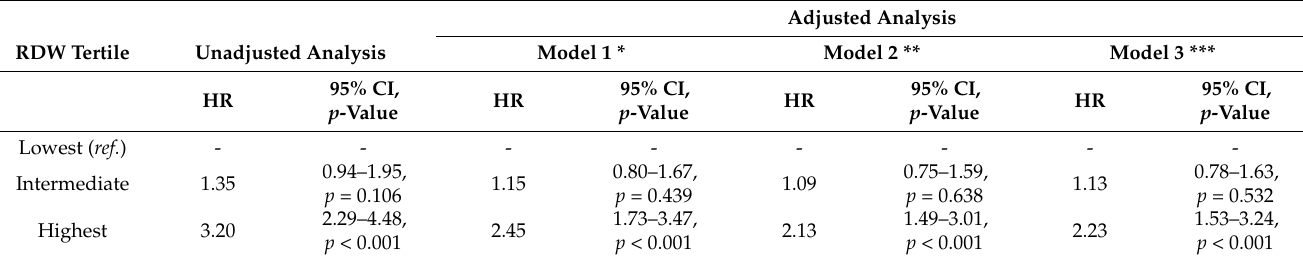
Table 4 . Unadjusted and adjusted Cox regression analysis for the composite outcome. Table 4. Unadjusted and adjusted Cox regression analysis for the composite outcome.